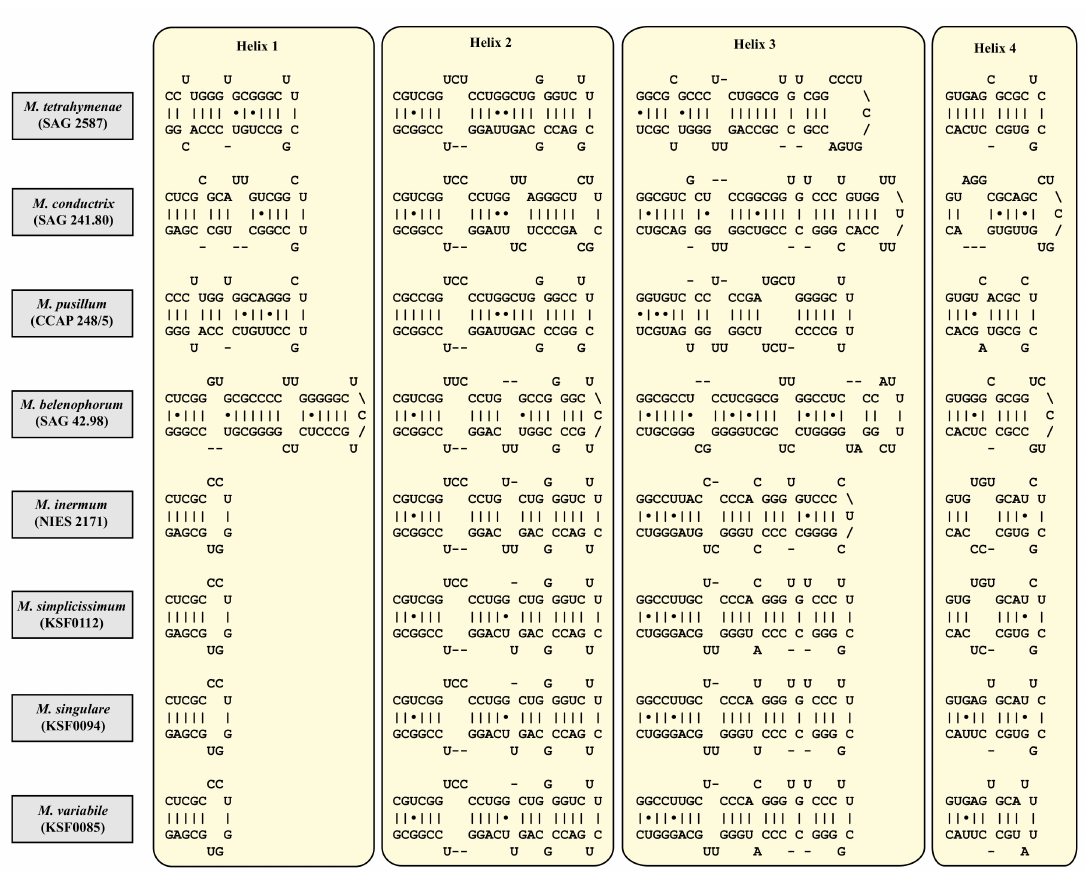
Figure 5. Secondary structure of the ITS-1 ( A ) and ITS-2 ( B ) rDNA of Micractinium tetrahymenae . The regions used for barcoding are highlighted in white boxes.